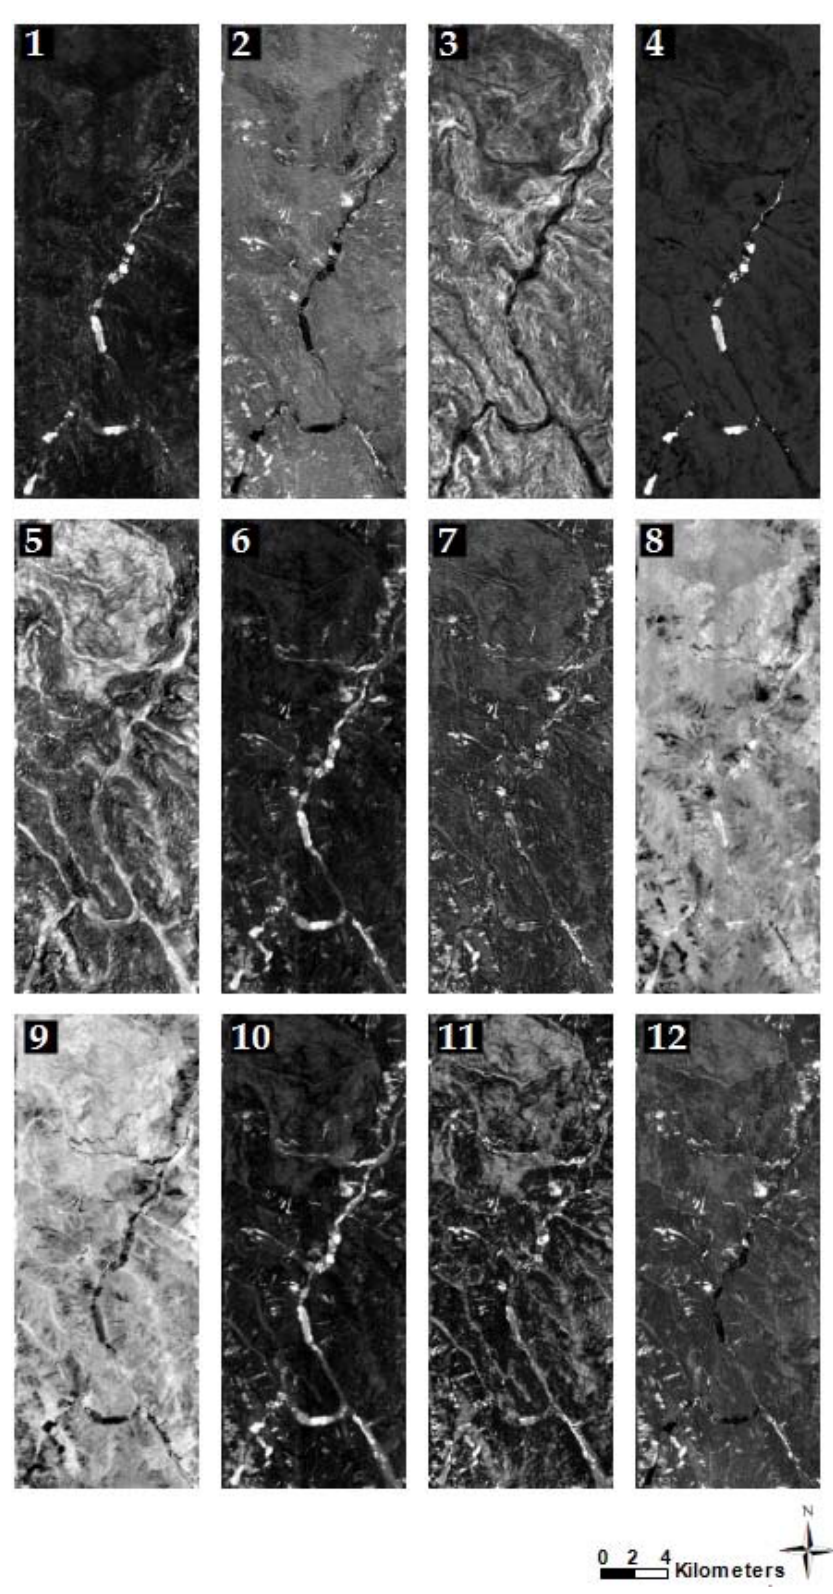
Figure 8. Reconstructed deep features of India’s case study. The stack of MNF features, slope, and NDVI layers were fed to our optimized CAE model (optimal parameters achieved in the tuning process), and the model’s outputs were 12 reconstructed features of the input data.